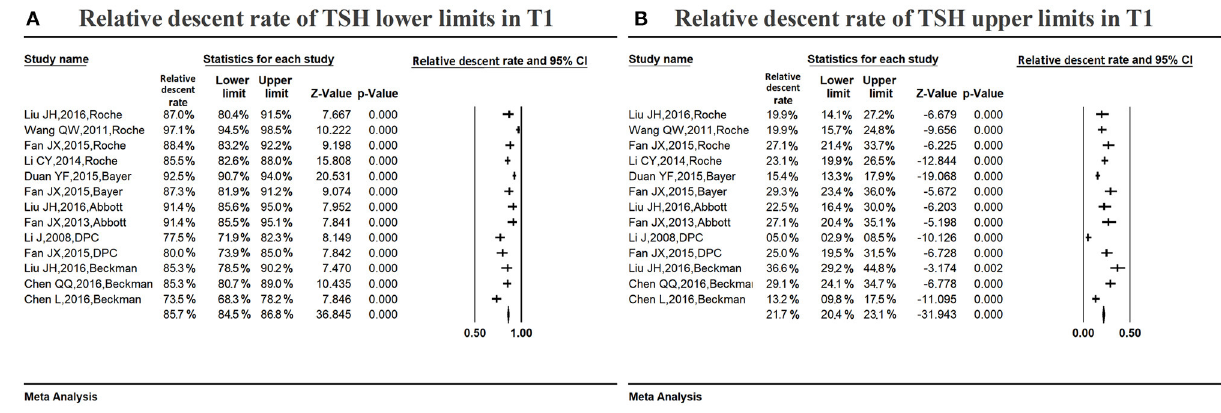
FIGURE 3 | Meta-analysis of the relative descent rate of TSH lower (A) and upper (B) reference limits in early pregnancy. Figure shows unadjusted relative descent rate of TSH lower (A) and upper (B) limit estimates in early pregnancy with 95% confidence limits for each study selected. Pooled relative descent rate estimates are represented as diamonds in this plot.